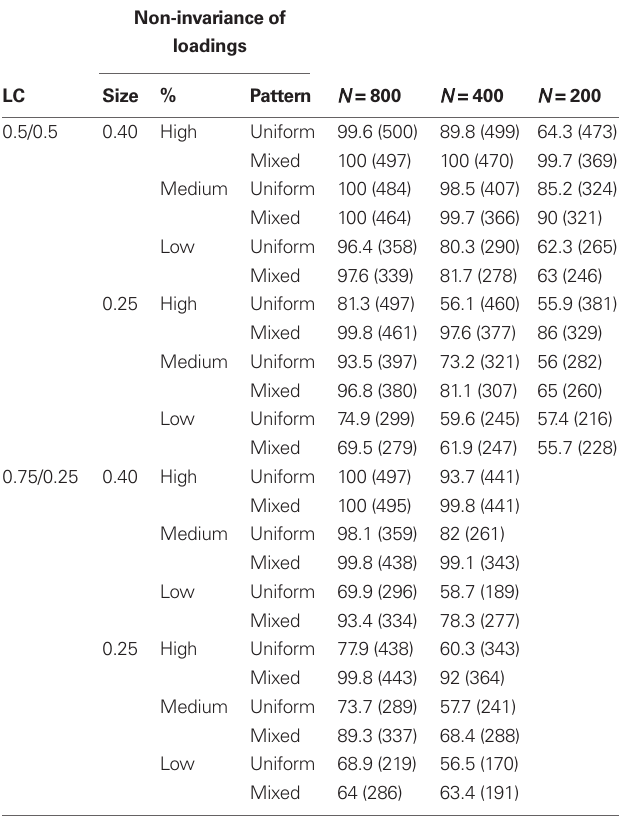
Table 4 | Percentage of correctly rejected LR tests for invariance of the factor loading matrix, number of replications in